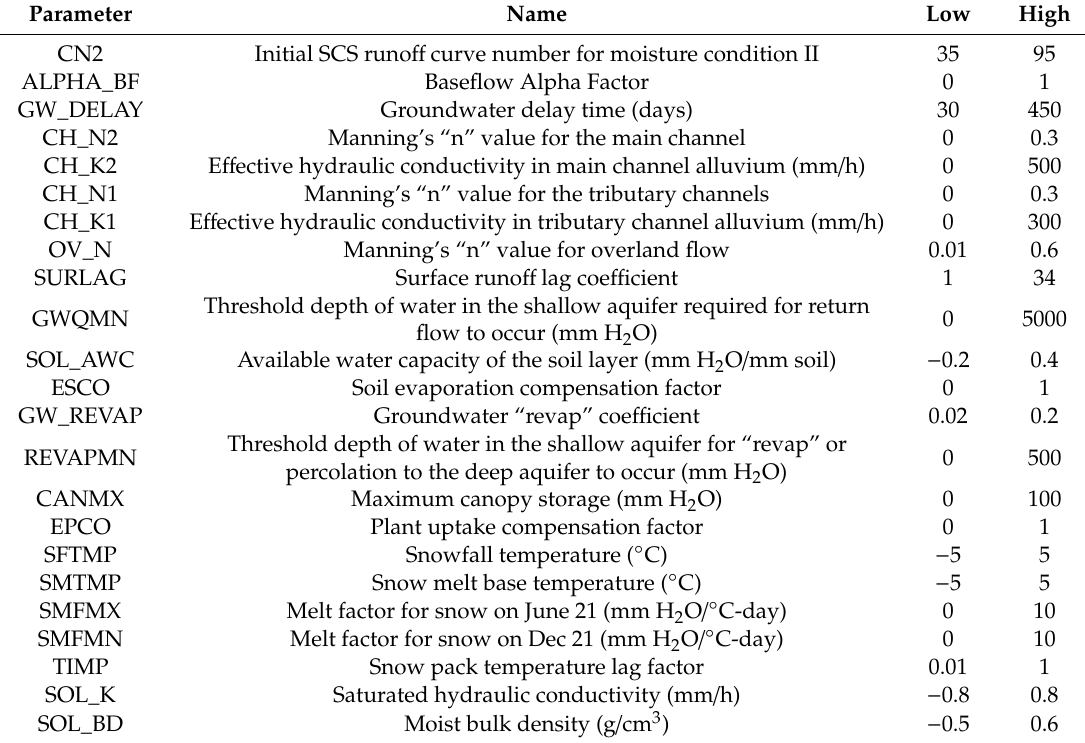
Table 3. Base_Q parameter ranges for all